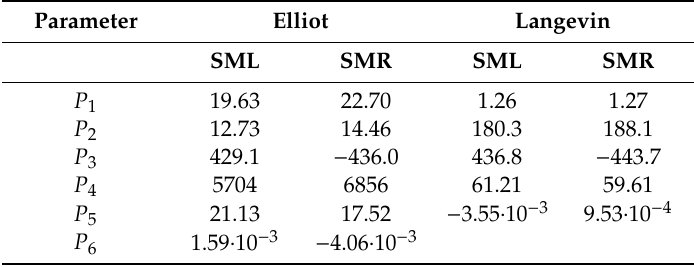
Table 10. Calculated parameters of the 9S20 major hysteresis loop.